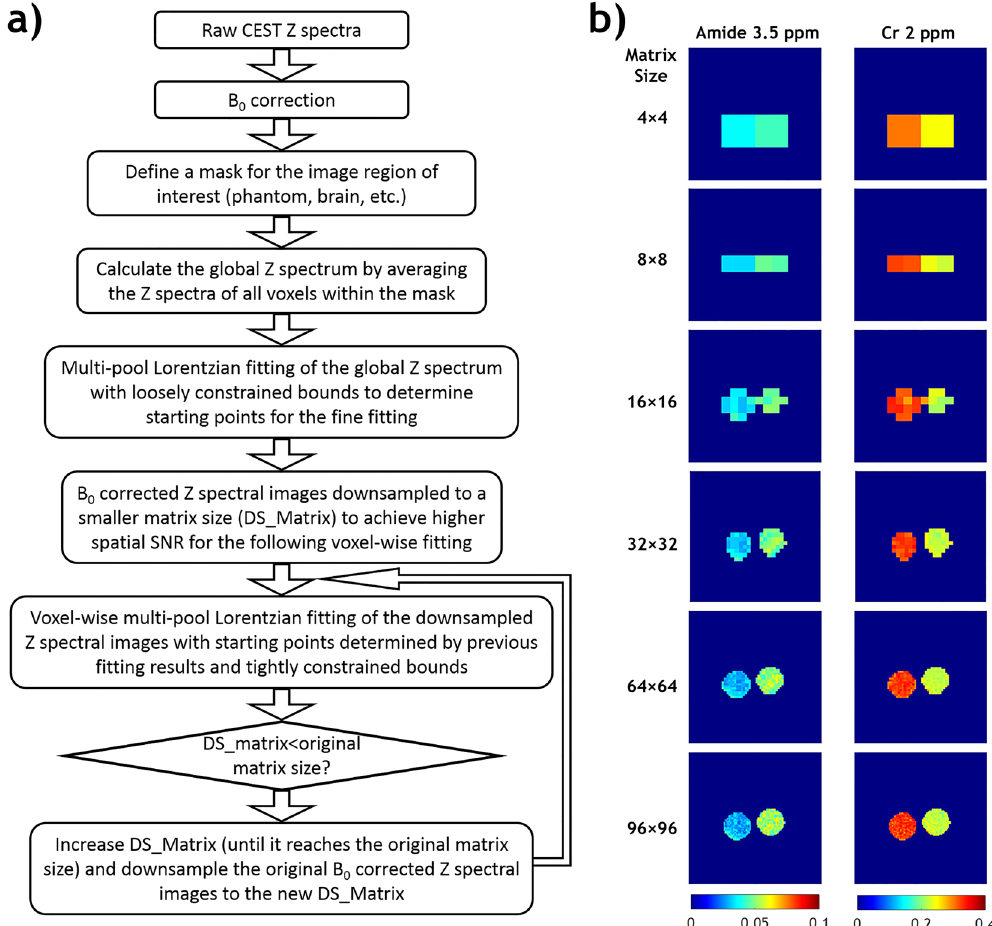
Figure 1. ( a ) Flow chart of data processing steps of the Image Downsampling Expedited Adaptive Least- squares (IDEAL) fitting approach. ( b ) The intermediate fitting results of iteratively less downsampled images from a two-compartment CEST